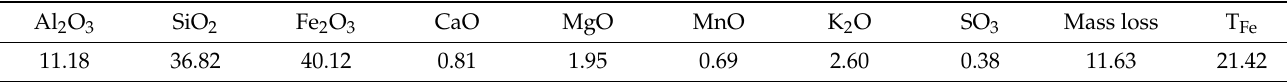
Table 1. Chemical composition of siderite /(wt.%).